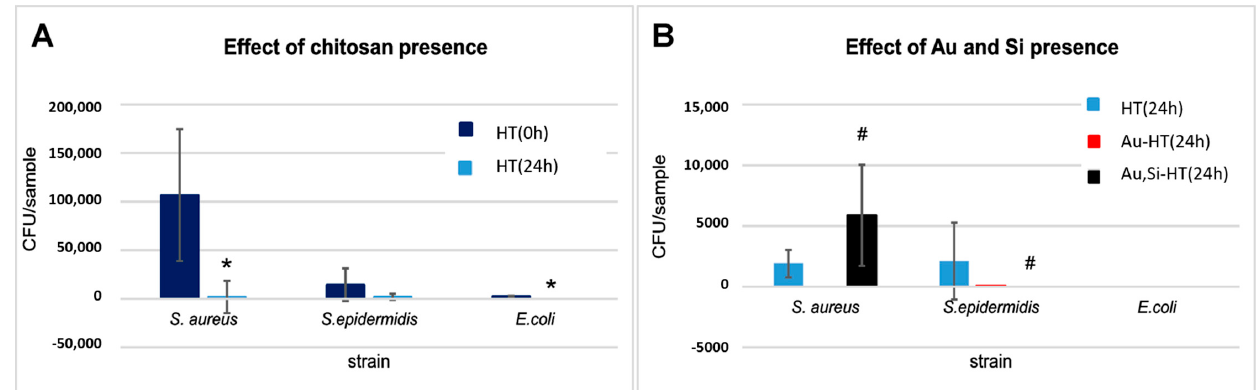
Figure 7. Effect of chitosan presence in the material ( A ) and effect of Si and Au presence in biomicroconcretes ( B ) observed after 24 h incubation with 3 bacterial strains. * significance compared to control at 0 h (Mann–Whitney test); # significance compared to control at 24 h (one-way ANOVA followed by Dunnett’s post hoc test). CFU: colony-forming unit.